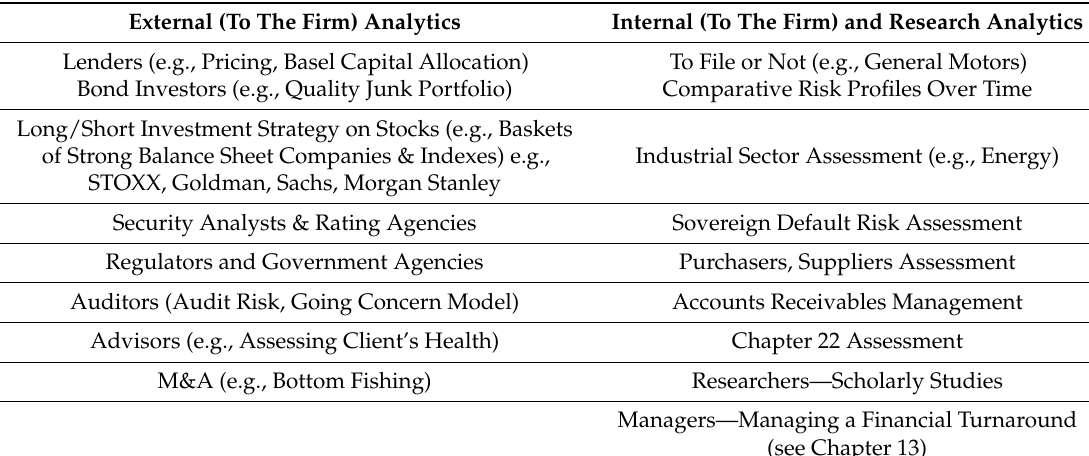
Table 1. Z-Score’s Financial Distress Prediction